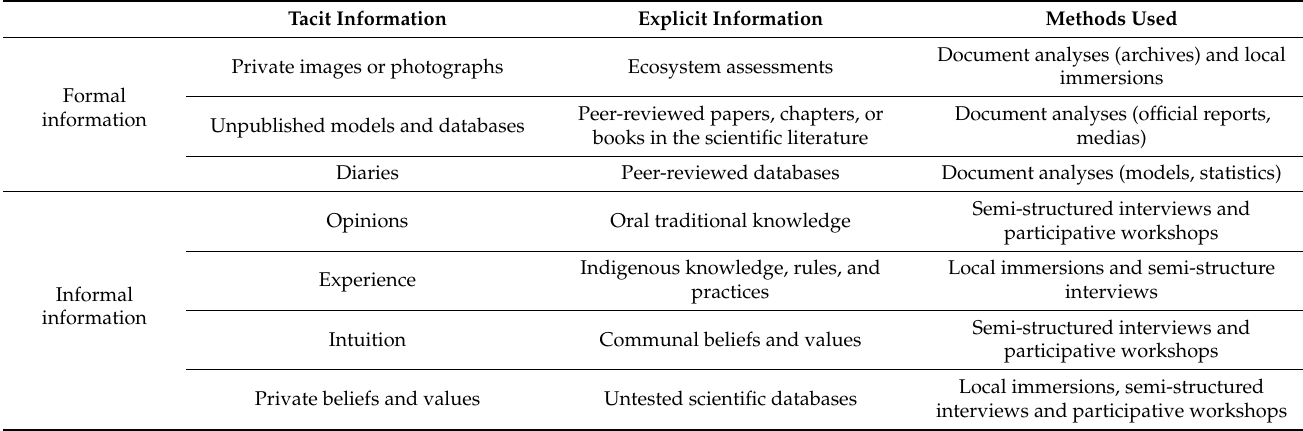
Table 1. A categorisation of information types and methods used to analyse them. Note: tacit information is known only by individuals, whereas explicit information is shared, with some level of agreement. The 3 shaded cells correspond to information types that we did not use for this study. (Adapted from Fabricius et al., 2006 [37]). Tacit Information Explicit Information Methods Used